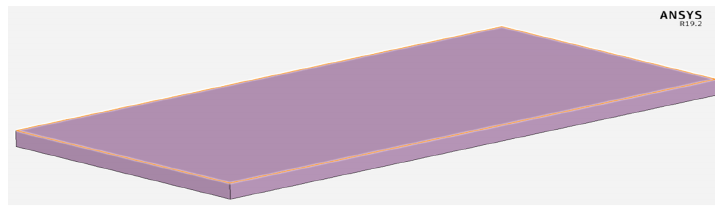
Figure 1. The computational domain for the 6061 aluminium alloy